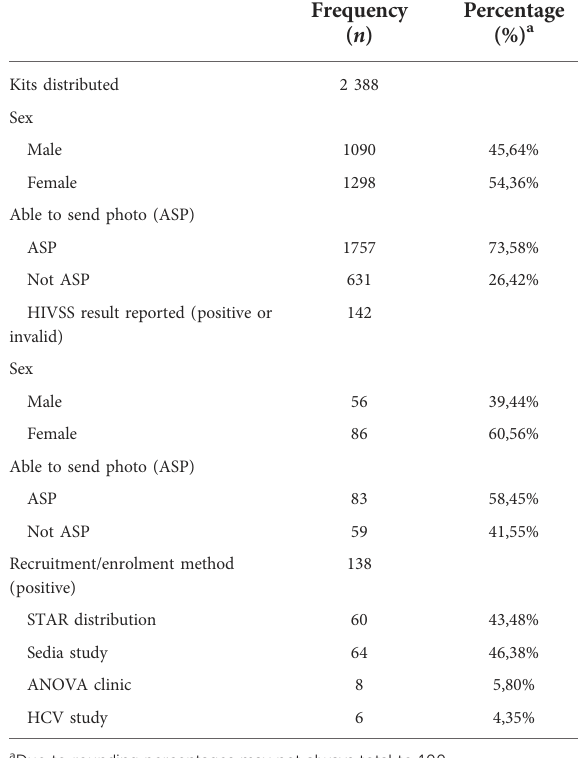
TABLE 2 Demographics from kit distribution and